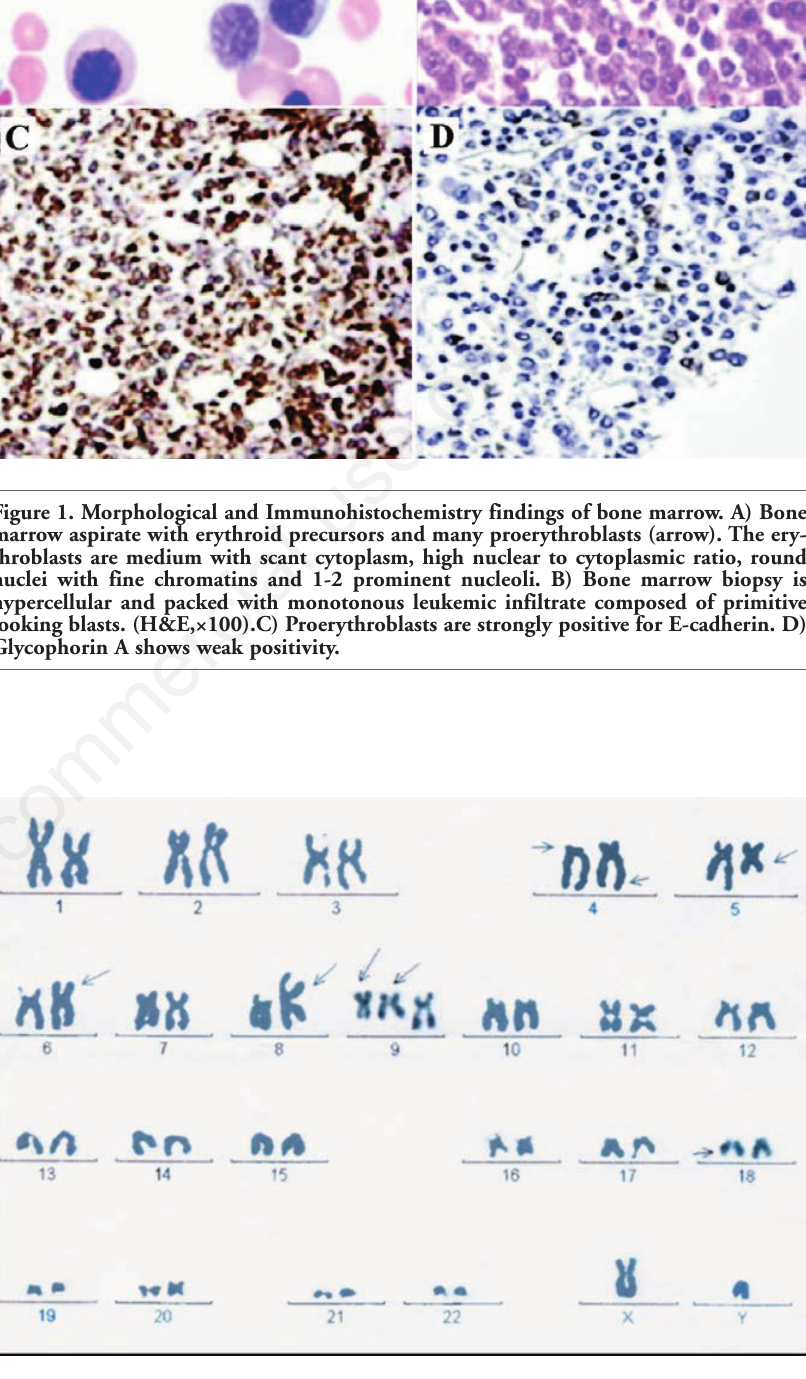
Figure 2. Complex karyotype with multiple chromosomal aberrations: 46-48,XY, add(4)(q?), del(4)(p?), del(5)(q23), add(6)(p23), del(7)(q22), t(8;9)(p11.2;q12), +del(9)(q22),